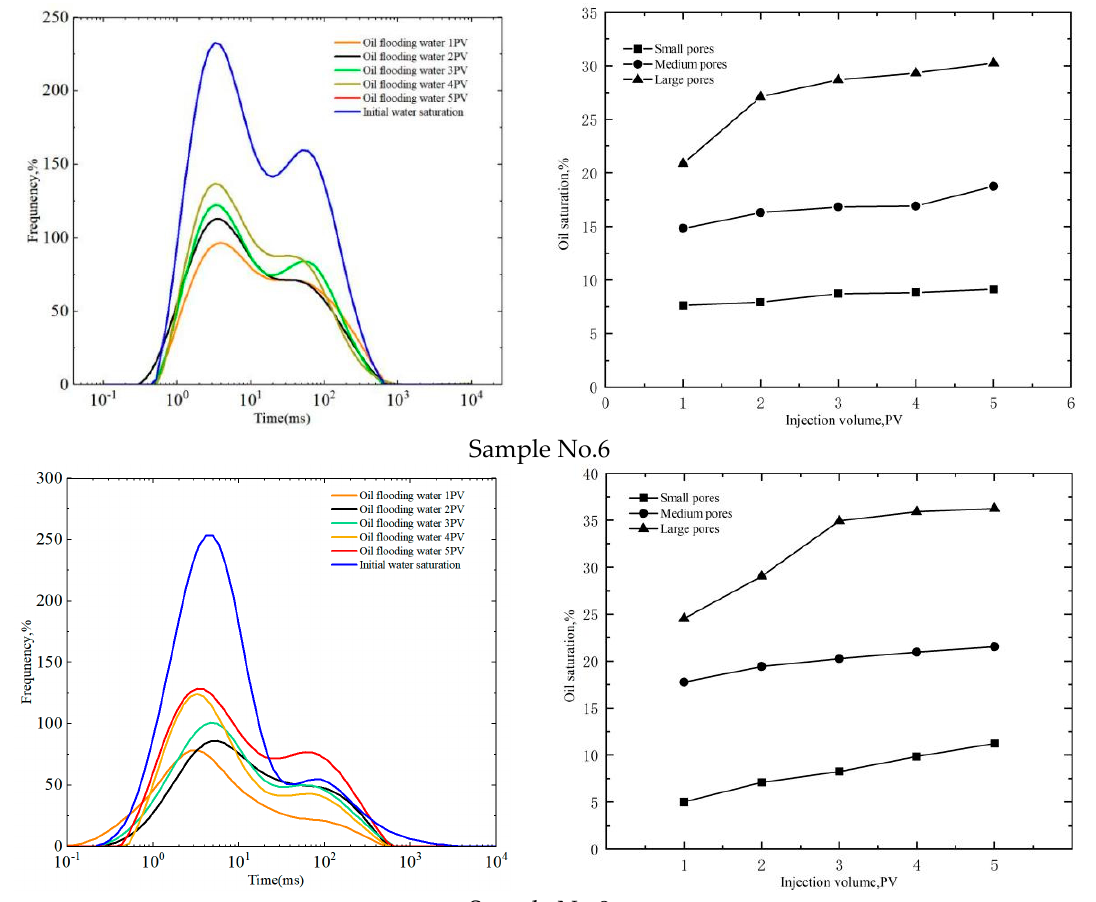
Figure 6. T 2 spectrum distribution of representative cores (Nos. 6 and 8) of Type I in the charging process and changes in oil saturation in different pores.